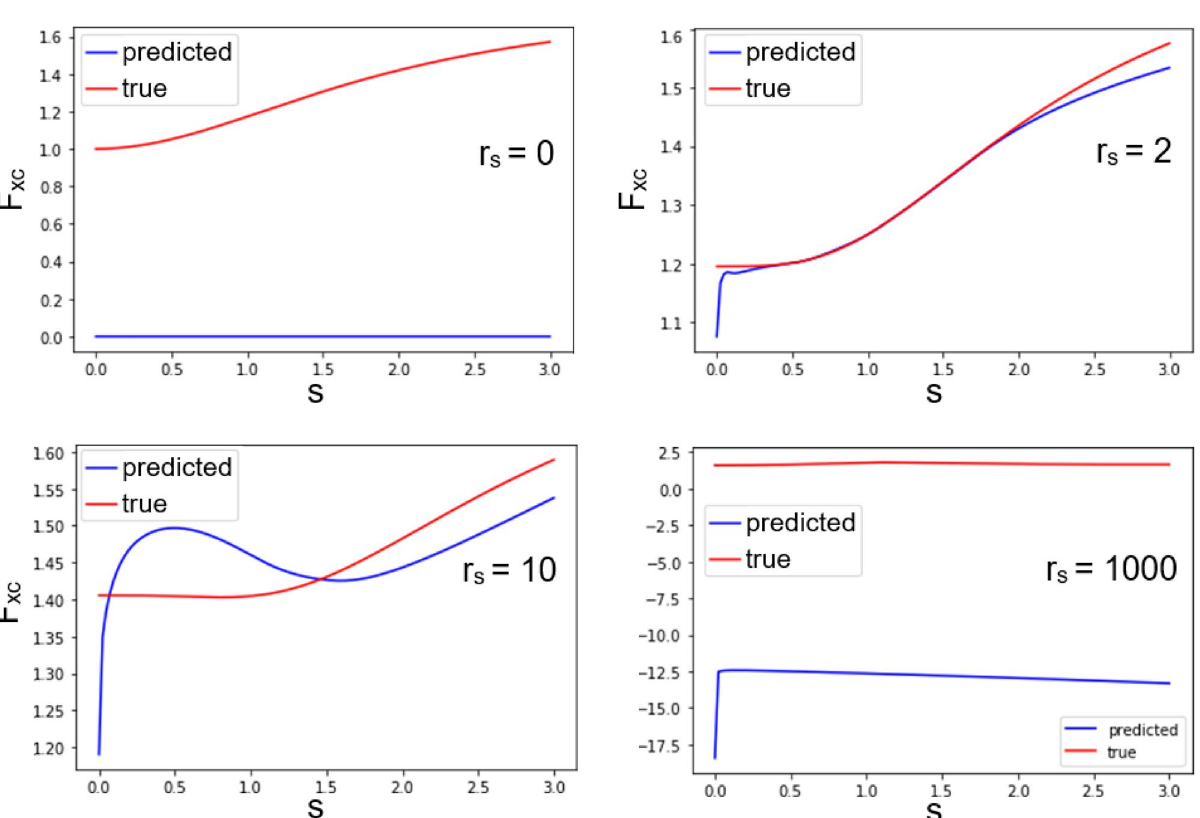
Figure 6. Enhancement factor F xc at fixed values of r s : 0, 2, 10, 1000. s is a reduced density gradient. There is a good agreement between the enhancement factors at r s = 2 densities, which is close to the most frequent densities in the training set. Also one can see that NN XC functional is bad in guessing asymptotic in low ( r s = 1000) and high ( r s = 0) limits of electron